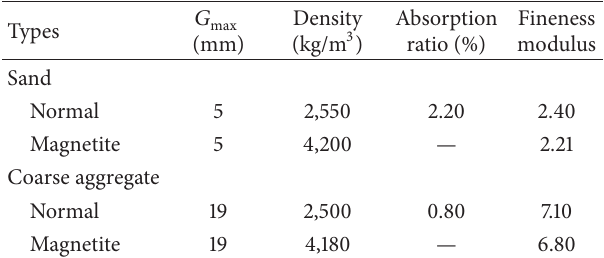
Table 3: Physical properties of